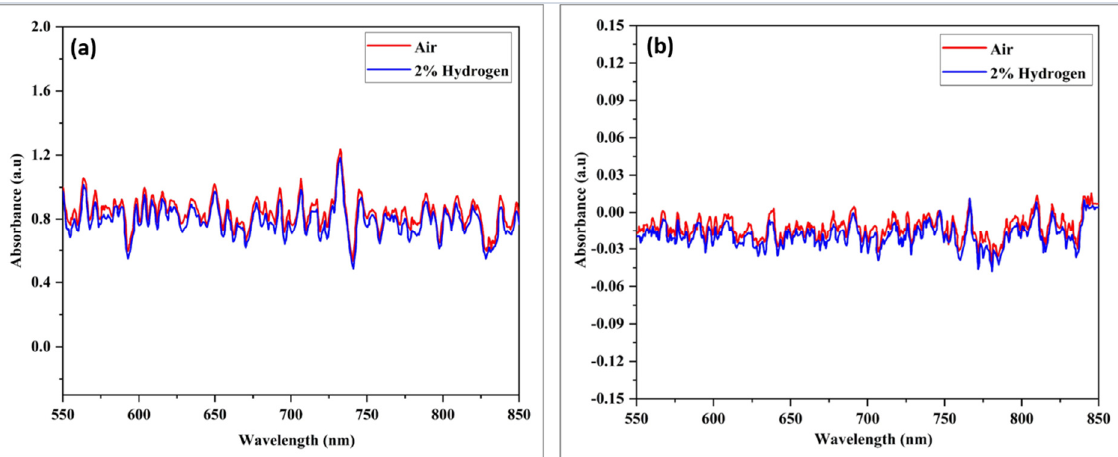
Figure 13. Absorption response versus uncoated wavelength ( a ) untapered, ( b ) tapered multimodal optical fibers when exposed to 2.00% H 2 at 200 °C.